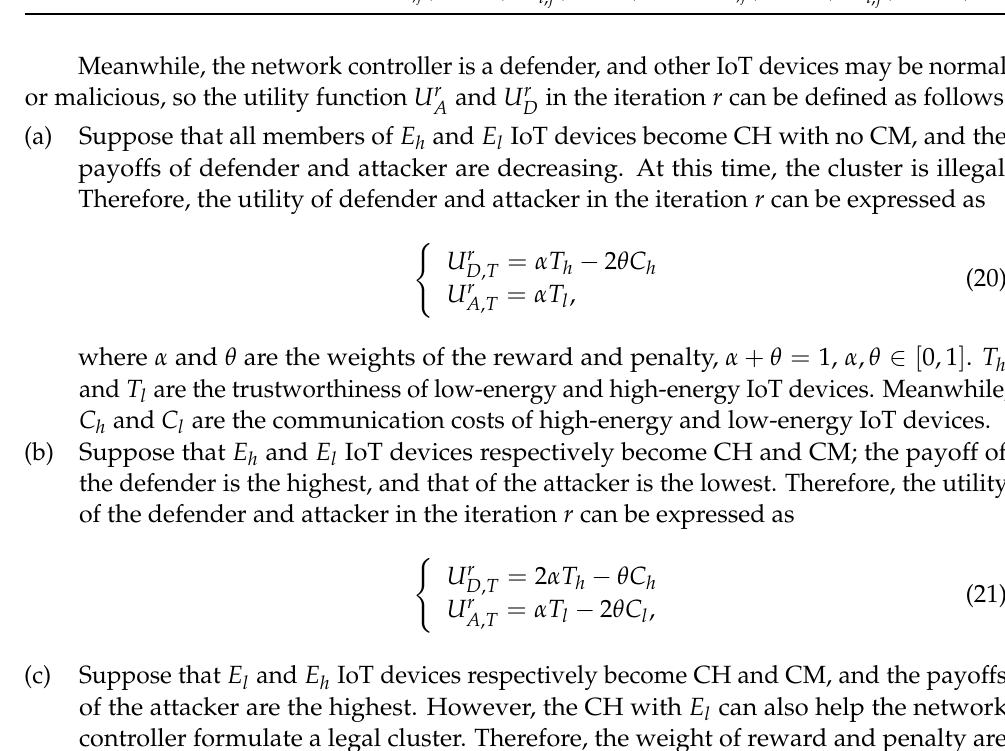
Table 1. The different payoffs under different behaviors of players. Strategy To Be CH To Be CM